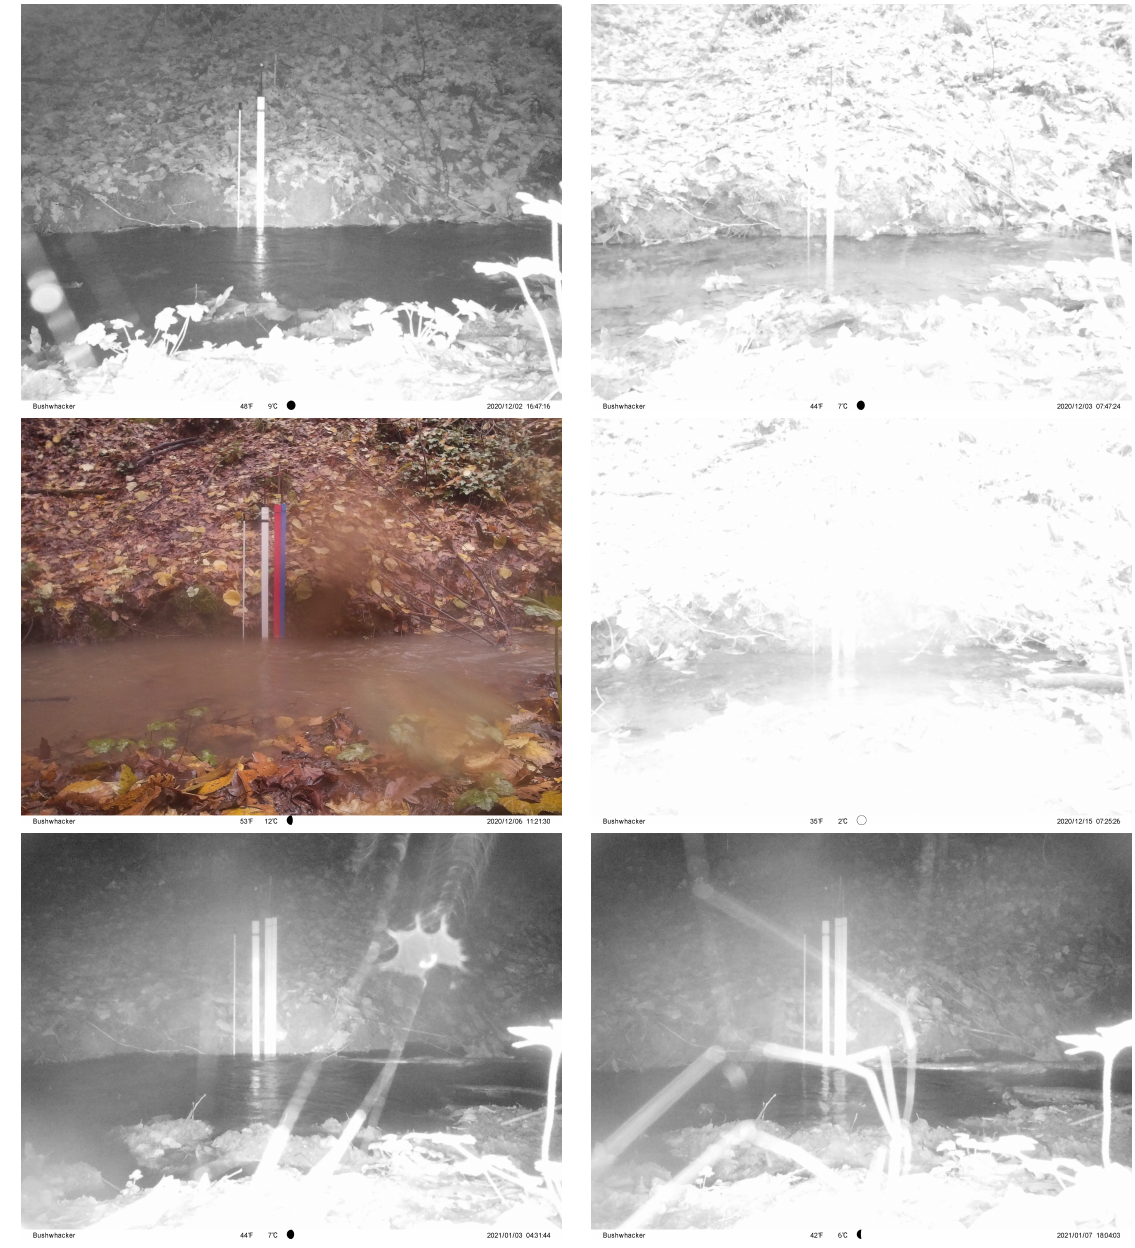
Figure 3. Examples of good-quality ( left ) and poor-quality ( right ) images taken during experiments E5–E7 (from top to bottom ). Right-side pictures led to large deviations from the benchmark. The optimal number of segmentation classes for RGB (T RGB ) and NIR (T NIR ) images are reported in Table 4 for both the pole and the white